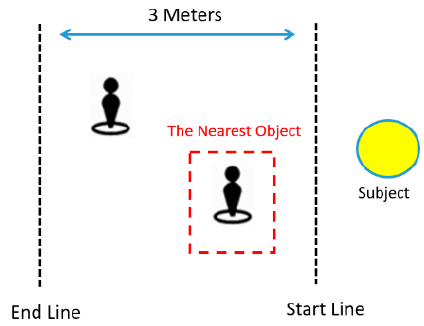
Figure 16. Journey with one or two pedestrians.